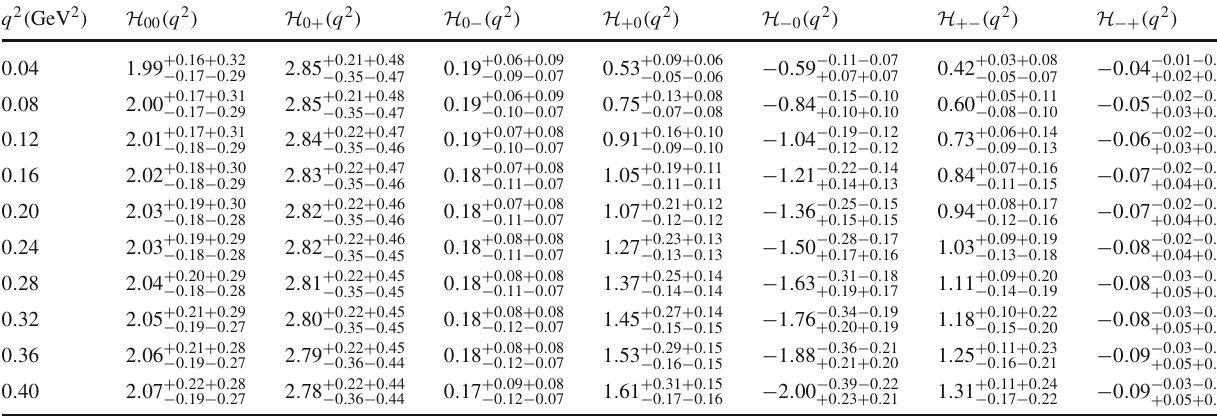
(cid:6) q 2 H ij ( q 2 ) in the large recoiled regions from